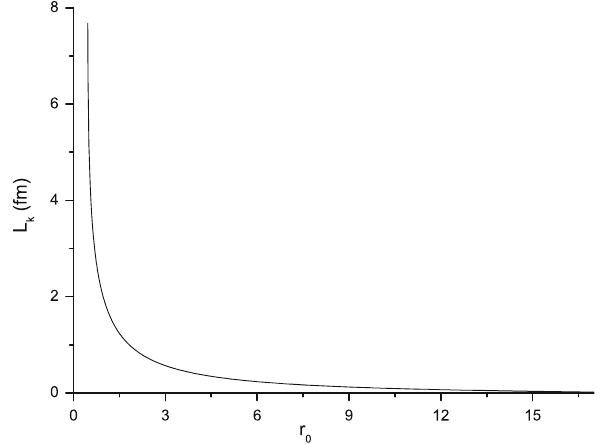
Fig. 1 L k versus r 0 . Here we take c = 0 . 02 GeV 4 and T = 200 MeV